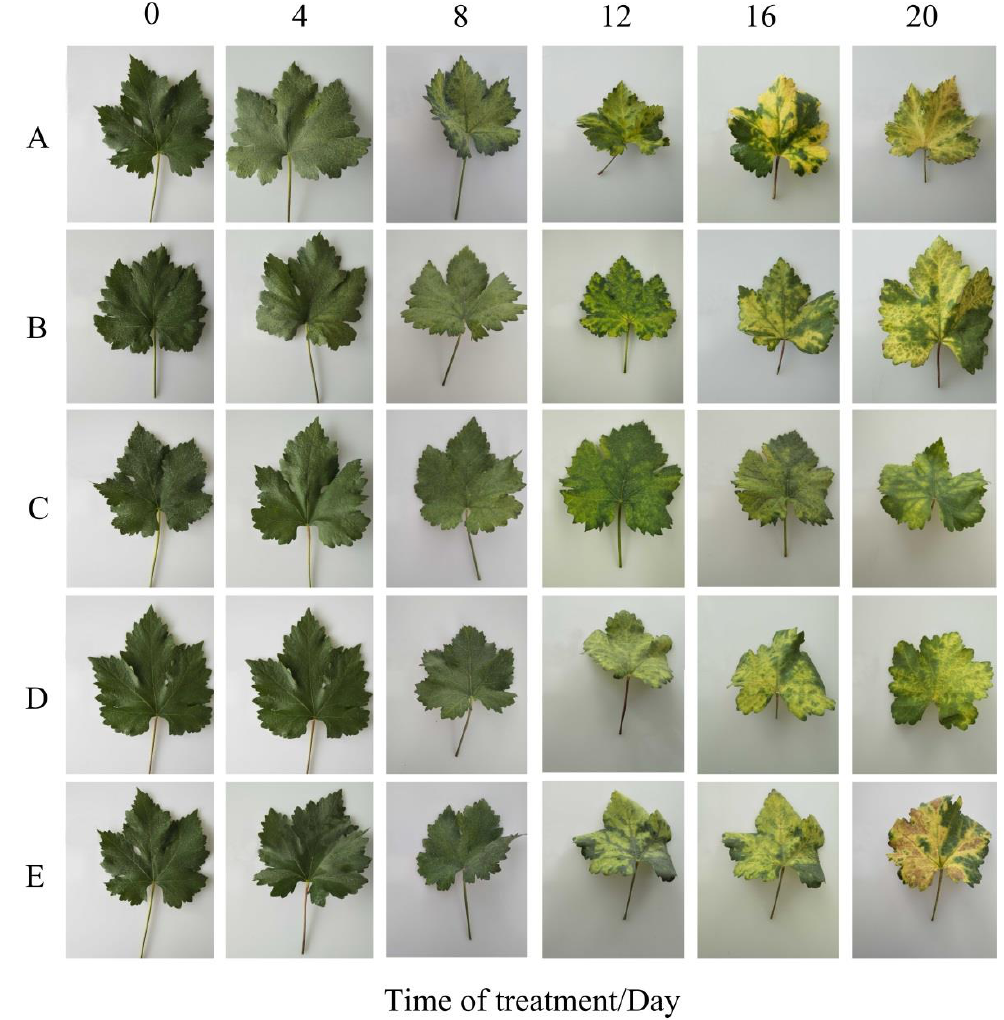
Figure 1. E ff ects of MT on phenotypical traits of grapevine leaves at di ff erent time courses (0, 4, 8, 12, Figure 1. Effects of MT on phenotypical traits of grapevine leaves at different time courses 16, and 20 d) after dark treatment. Grapevine leaves were treated with MT and labeled with ( A ) as (0, 4, 8, 12, 16, and 20 d) after dark treatment. Grapevine leaves were treated with MT and control (distilled water), ( B ) 50 µ M, (C ) 100 µ M, ( D ) 200 µ M, and ( E ) 500 µ M MT. All the leaves were labeled with ( A ) as control (distilled water), ( B ) 50 μM, (C ) 100 μM, ( D ) 200 μM, and ( E ) 500 incubated in a dark growth chamber where temperature and RH were held at 28 ◦ C and 80%–90% μM MT. All the leaves were incubated in a dark growth chamber where temperature and without light, respectively. For each treatment, 50 leaves were RH were held at 28 °C and 80%–90% without light, respectively. For each treatment, 50 leaves were considered.